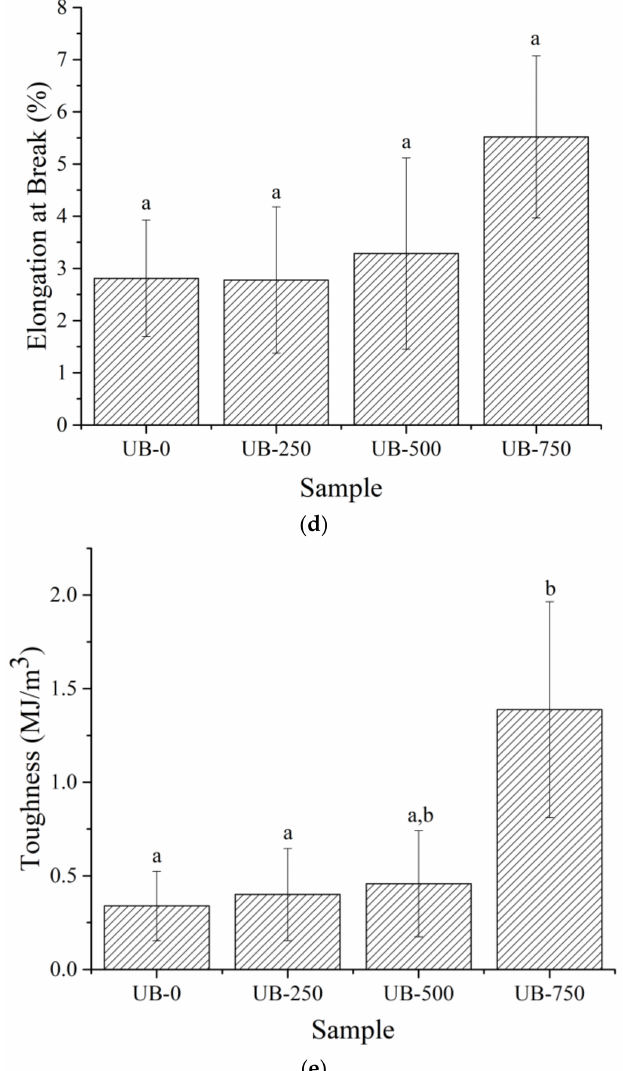
Figure 5. Stress–strain curve of nonsonicated and sonicated films ( a ). Average values of TS ( b ), TM ( c ), EB ( d ), and TN ( e ) for all tested films. Different letters (a,b) for each data point indicate a significant difference in mean values ( p ≤ 0.05). The same letter indicates that values are not significantly